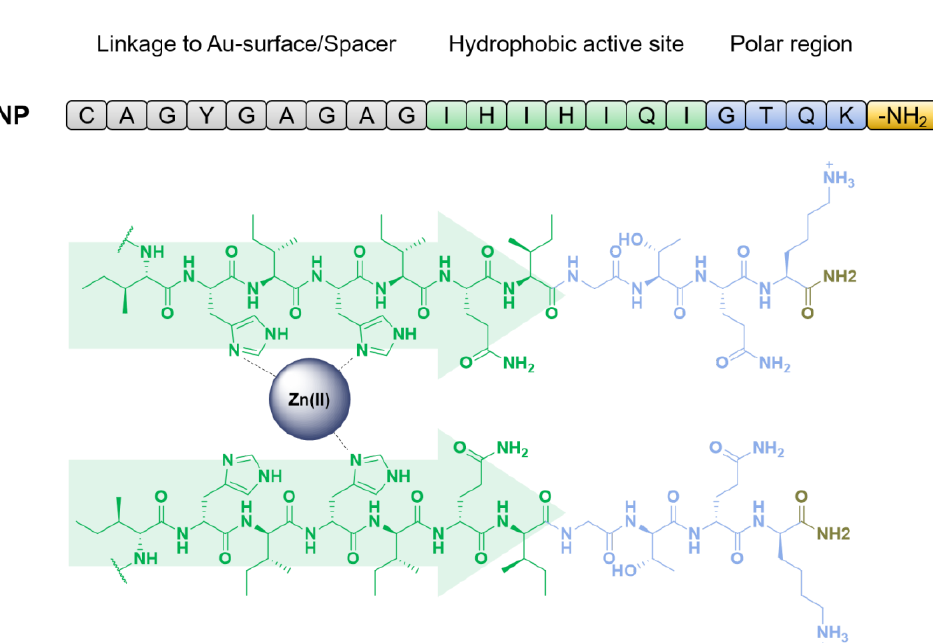
Figure 1. (Top) Peptide sequence of designed and studied IHQ-NP and (bottom) structures of the polar region (blue) and hydrophobic segment (green) of IHQ-NP and the corresponding 3 His Zn(II)- center formed by interstrand interactions between two individual β -sheet forming IHQ-NP peptides (green arrow).